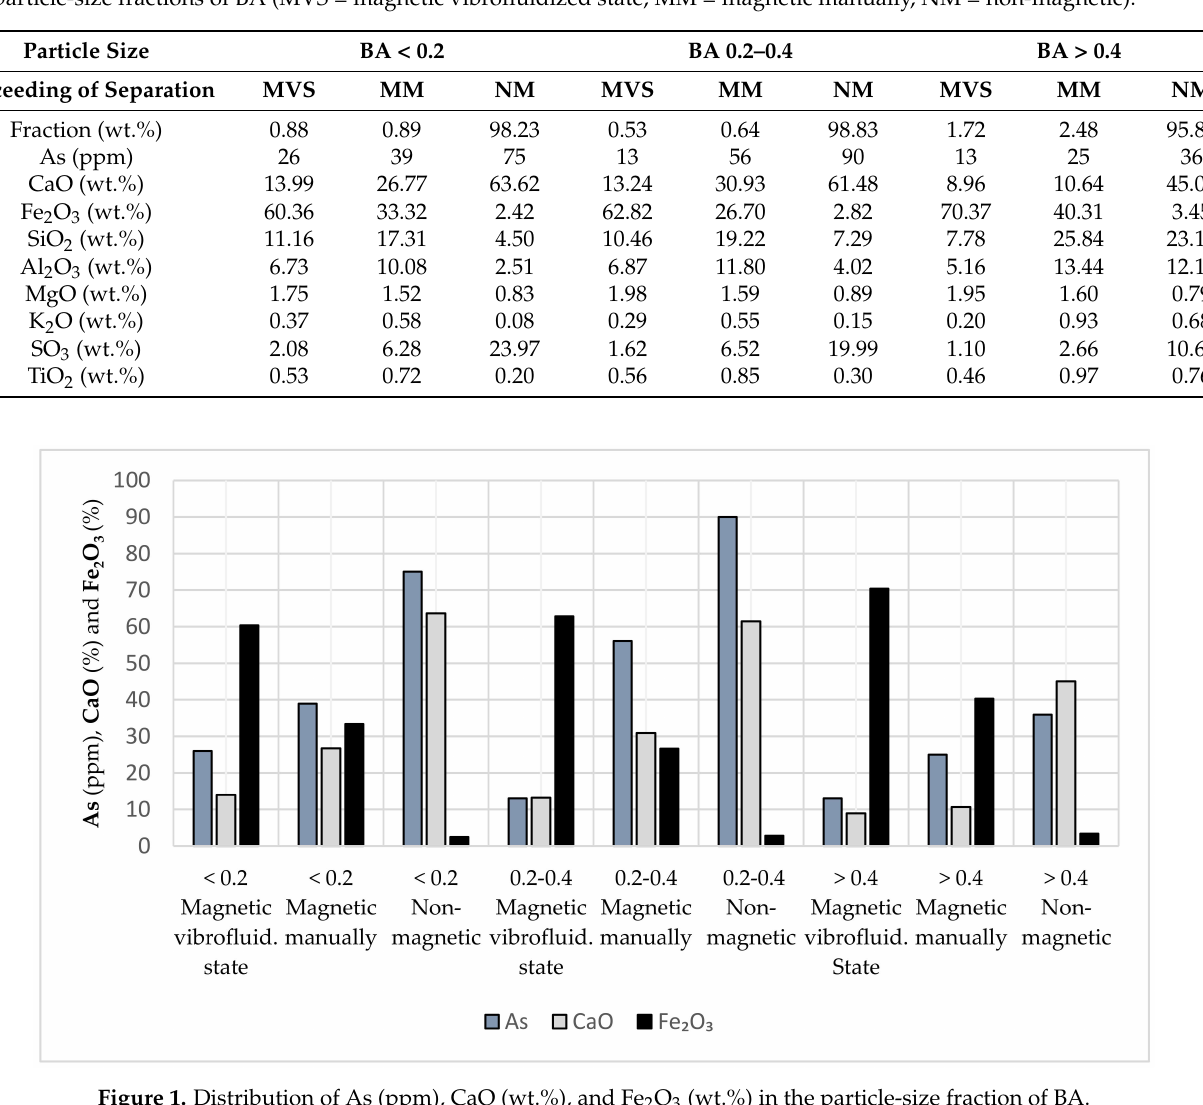
Table 1. Concentrations of the studied elements in magnetic concentrates and non-magnetic residues prepared from three